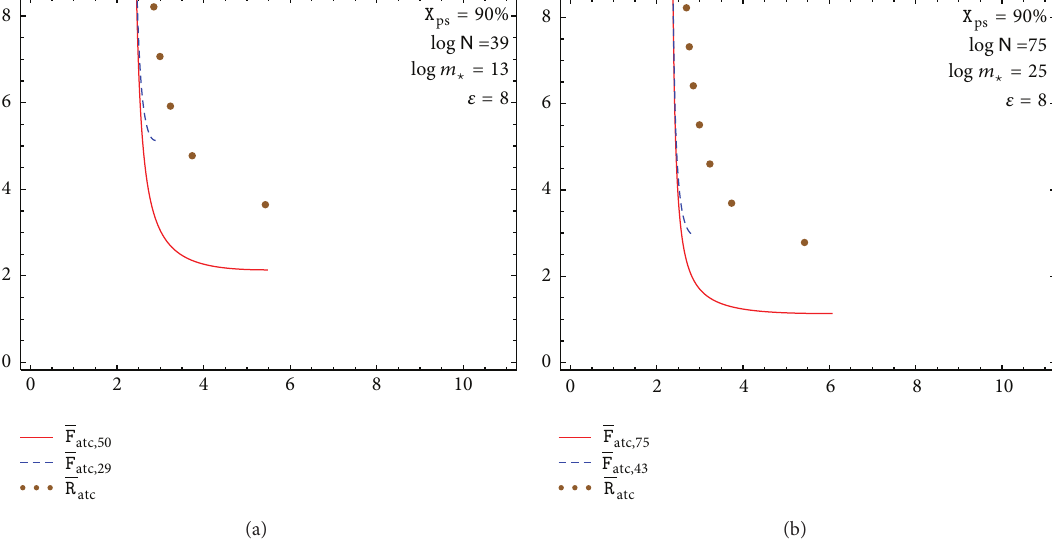
Figure 3: The adjusted tradeoff coefficients in relation to the precomputation coefficients for the perfect fuzzy rainbow, perfect rainbow, and nonperfect fuzzy rainbow tradeoffs at 90 % success rate (bottom: X